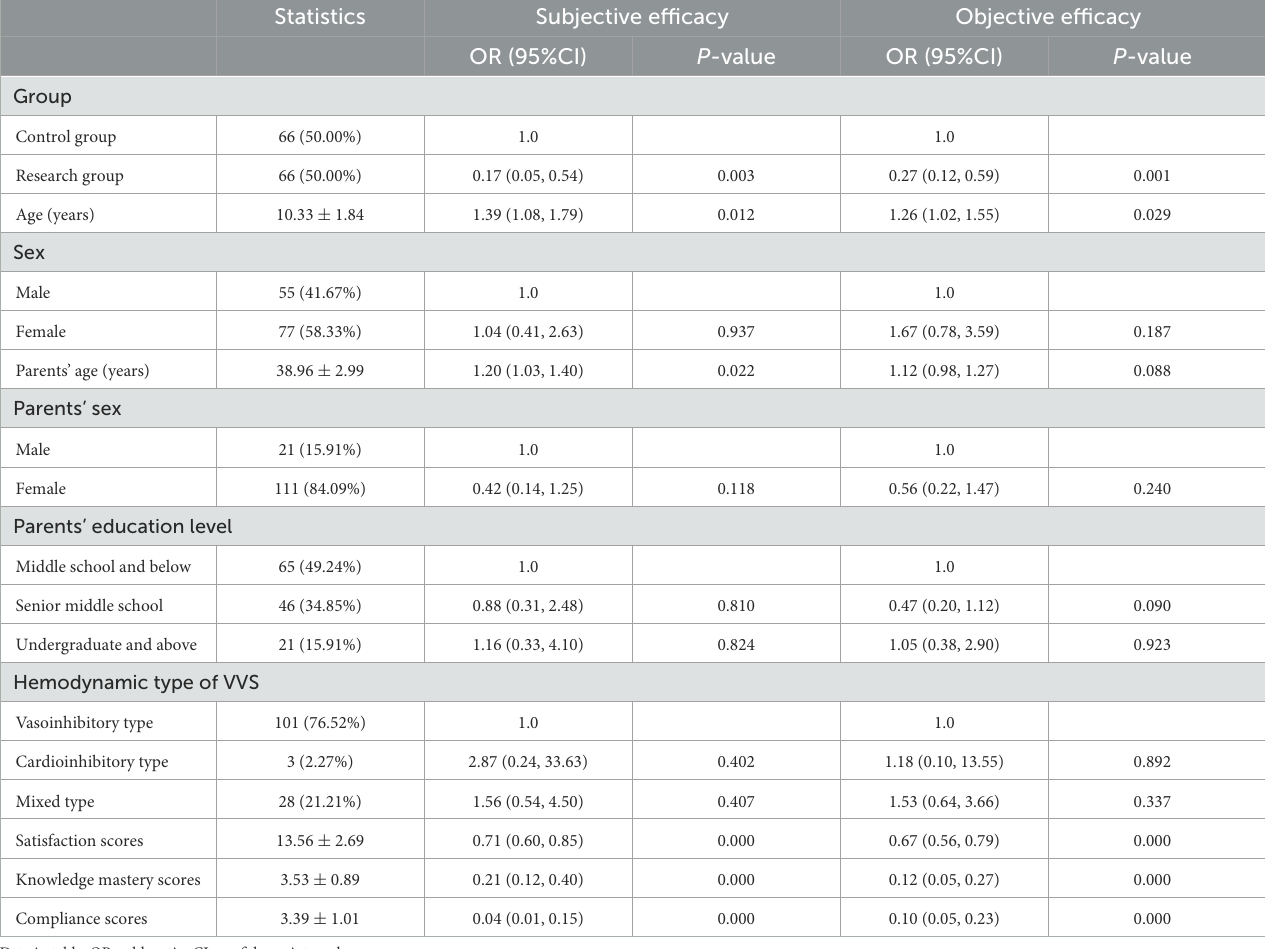
TABLE 2 Univariate analysis of subjective efficacy and objective efficacy [ n = 132, Mean ± SD/ n